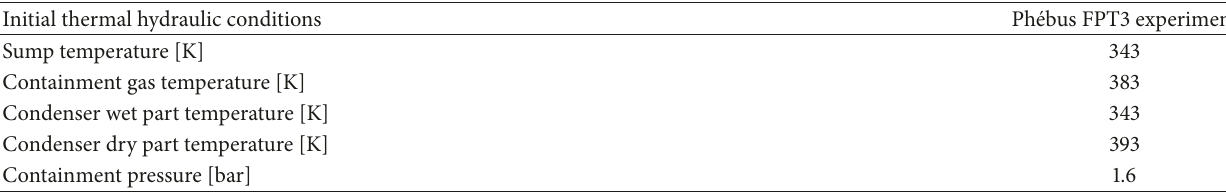
Table 5: Initial thermal hydraulic conditions of the washing phase [25].